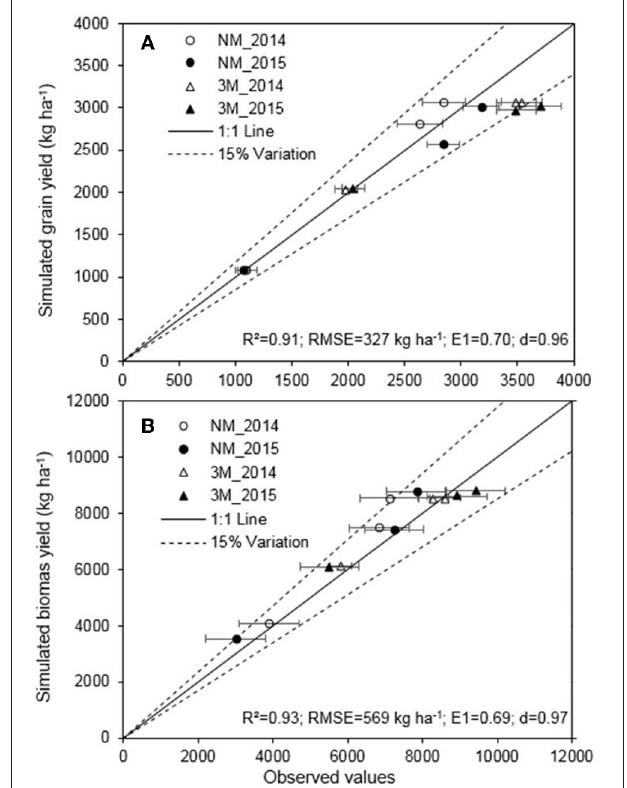
FIGURE 2 | Model validation: comparison between observed and simulated maize LAI (A) and aboveground biomass (B) for all treatments not used during calibration (6 dates of measurement per treatment from 20 to 90 days after sowing) as affected by combined application of 0 (NM) or 3 (3M) t ha − 1 of manure and 0 (NF), 50 (50F), or 100% (100F) of the recommended mineral fertilization rate (broadcast fertilizer) over 2 years. Error bars = standard deviation ( n = 3); RMSE, root mean-square error; E1, coefficient of efficiency; d, index of agreement.